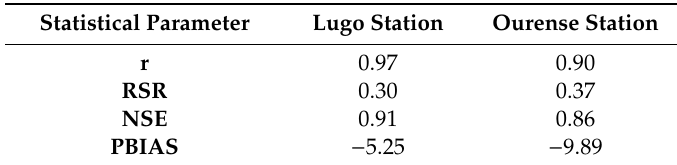
Table 3. Statistical analysis of the performance of forecasted river flow respect to measured data during the period